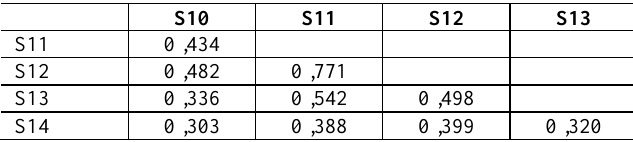
Table 3: Correlation coefficients for Structure (S)